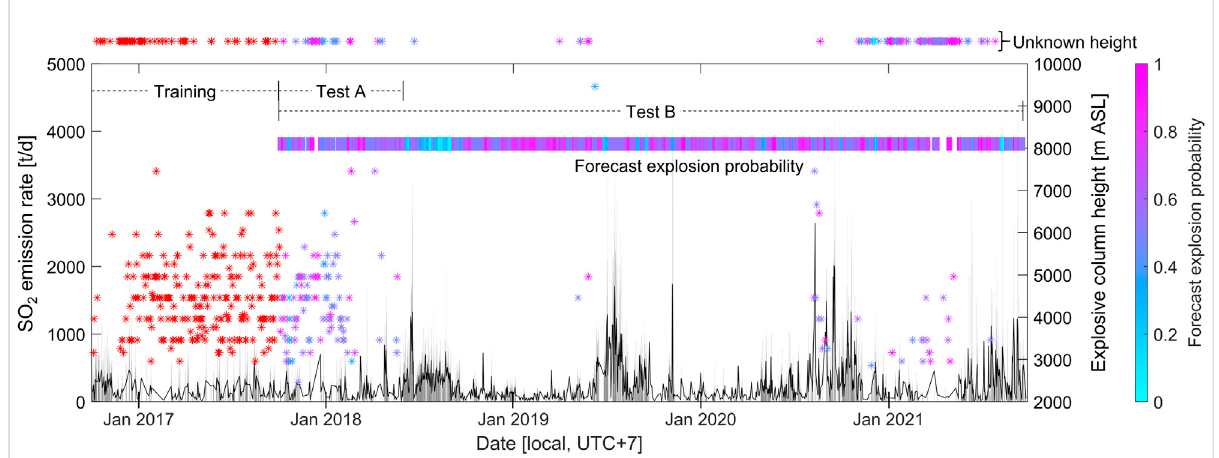
FIGURE 2 SO 2 emission rates and explosive events measured at Sinabung Volcano from 1 October 2016 to 30 September 2021. Vertical grey bars depict therangeofinstantaneous SO 2 emissionratesmeasuredbythescannersintheDOASnetwork,whilethesolidblacklinerepresentsthedailyaverage passive emission rate (see text for details). The timing and column height of explosions is indicated by the position of the stars. Explosive events with unquanti fi edcolumnheightsareindicatedbystarsatthetopoftheplot.Thetime windows usedfortrainingandtestingexplosionforecasts are also indicated at the top and labeled ‘ Training ’ , ‘ Test A ’ , and ‘ Test B ’ . Starting on 1 October 2017, the forecast daily explosion probabilities are represented by the horizontal bar in varying colors, with the color scale given at right; stars indicating column heights are color-coded according to the last valid forecast explosion probability before the corresponding explosion occurred (compare Figure 5C); red stars indicate explosions that occurred during the training period when no forecast was